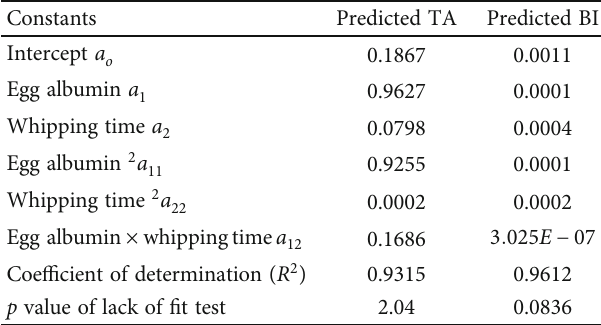
Table 4: Regression coe ffi cients, coe ffi cient of determination ( R 2 ), and lack of fi t values for the second-order fi tted models corresponding responses, TA (%) and BI (%) with x 1 = egg albumin (%) and x 2 = whipping time (min).